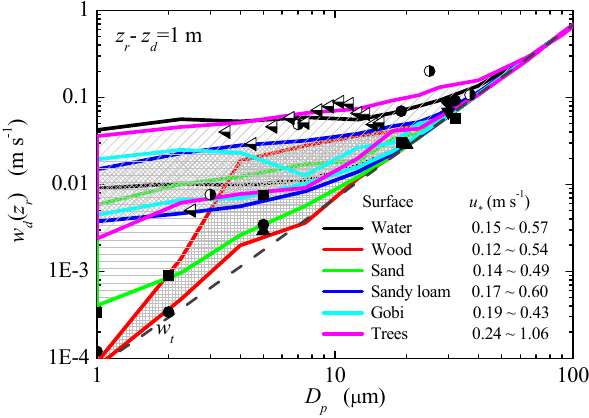
Figure 13. Comparison between the results of our measurements and other experiments. The lines and the shaded areas represent the range of dust deposition velocity over different surfaces, extracted from our data set. The dots are the results of the existing studies corresponding to Fig. 1 (with the same shape), but are recalculated to z r = ( z d +